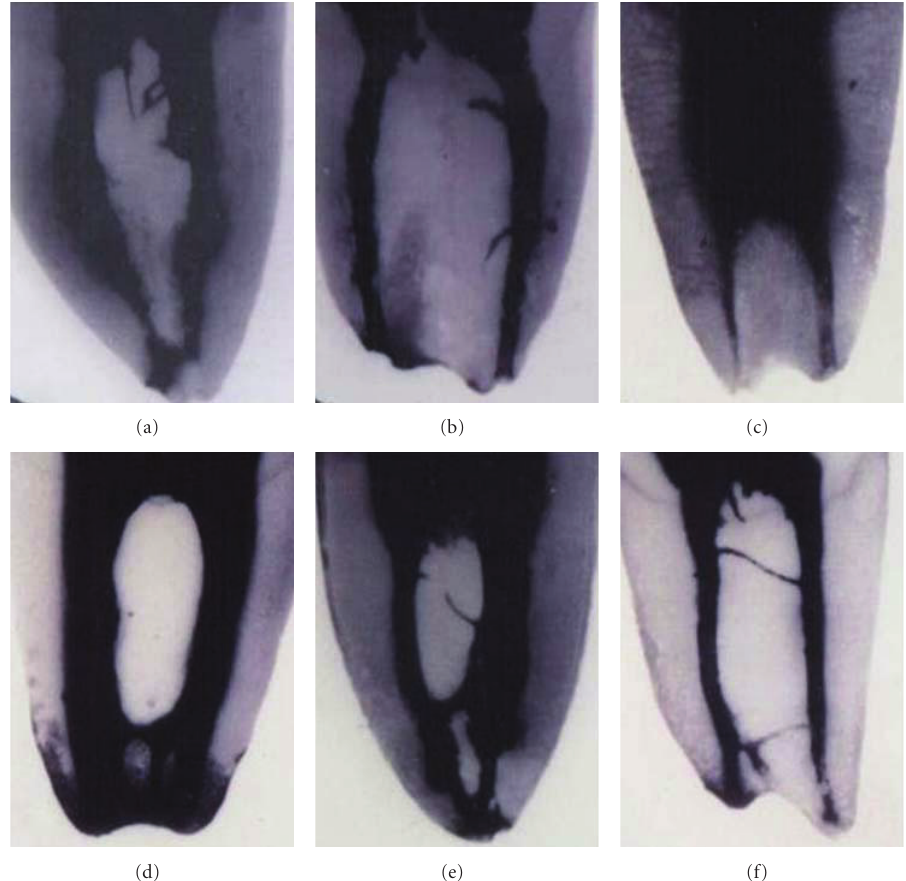
Figure 1: Mesial root canal configurations observed in this study. (a) type II, (b) type IV, (c) type V, (d) type VI, (e) type (2-1-2-1), and (f) isthmi in the cervical and apical third of the root. Table 2: Canal configuration and the type of root canal in mandibular first molars. Group (no. of roots)